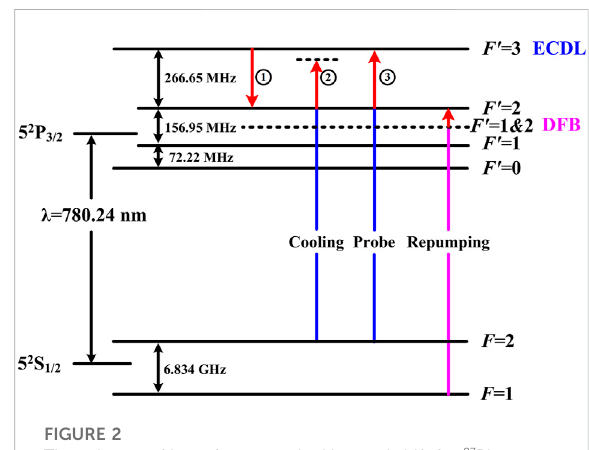
FIGURE 2 The scheme of laser frequency locking and shift for 87